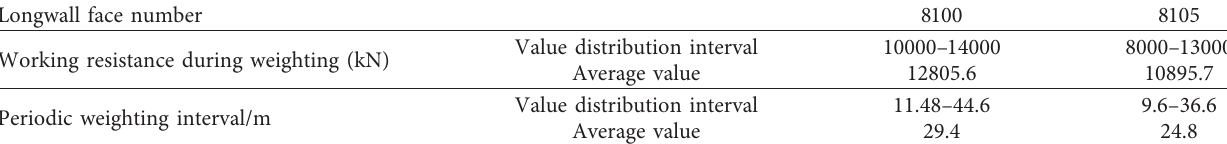
Table 5: Comparison of underground pressure in the middle of No. 8105 and 8100 longwall face [27]. Longwall face number 8100 Value distribution interval Working resistance during weighting (kN) Periodic weighting